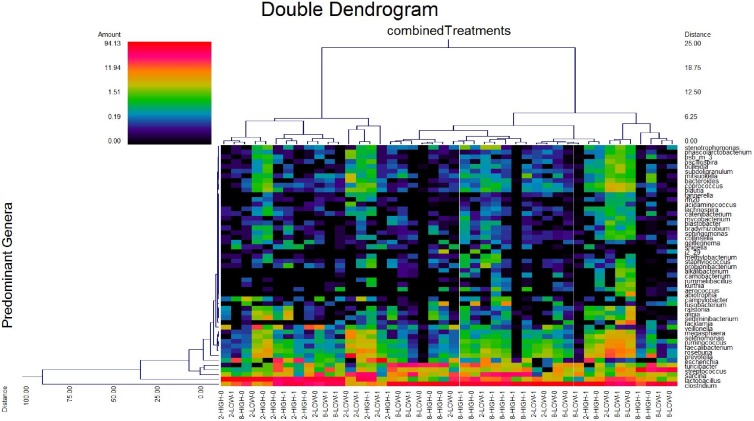
Dual hierarchical clustering dendogram of the fifty most abundant bacterial genera among the pig samples collected at 2 and 8 weeks post-weaning and fed HIGH or LOW complex diets with (1) or without (0) in-feed antibiotic.Experimental diets were fed from 0 to 6 weeks post-weaning. All pigs received the same grower/finisher diets thereafter. The double dendrogram is based on the Wards clustering and Manhattan distance methods. The heat map depicts the relative percentage of each genus for each sample. The relative distance scale for the left y-axis is provided in the lower left corner of the figure. The colour scale for the heat map is shown in the upper left corner of the figure.